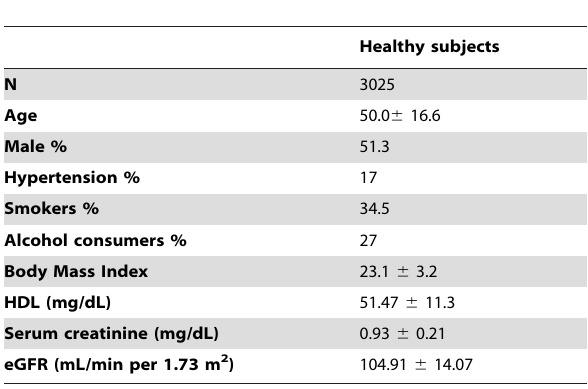
Table 1. Basic characteristics of the study subjects.